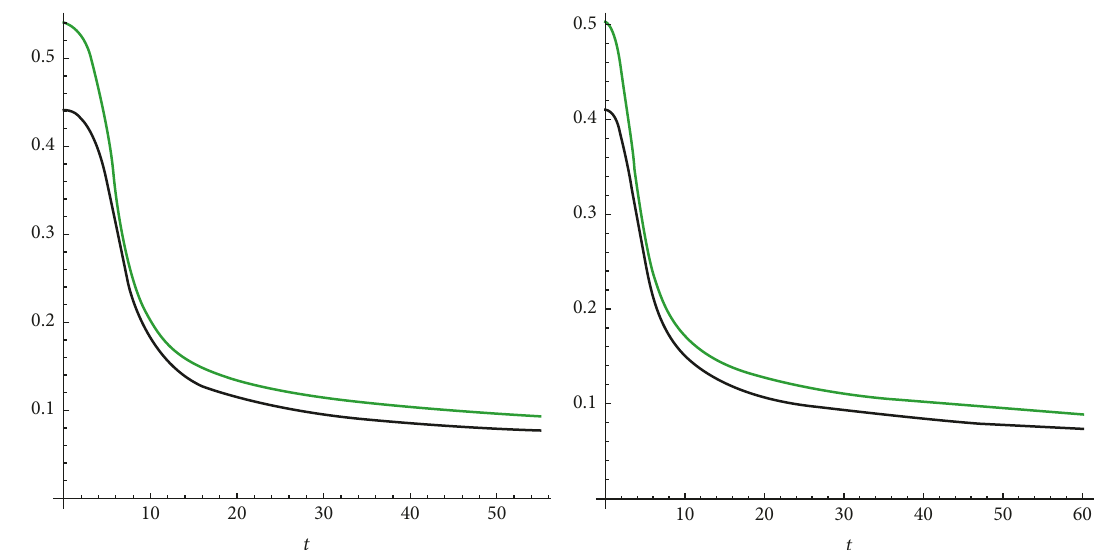
Figure 23: Plots of 𝐻(𝑡)/√𝑀 0 (black) and 𝐻 𝑐 (𝑡)/√𝑀 0 (green) for the orange and yellow trajectories in the potential Φ + . For better clarity, we truncated the plot at 𝑡 = 60 s. For both trajectories, inflation stops after a finite time (indicated in the text), though this is not visible at the scale of the